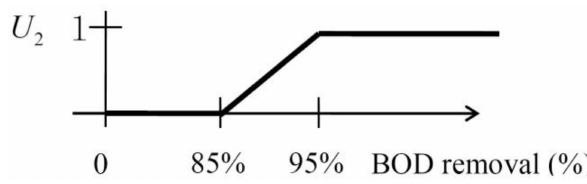
Figure 4. Membership function of BOD